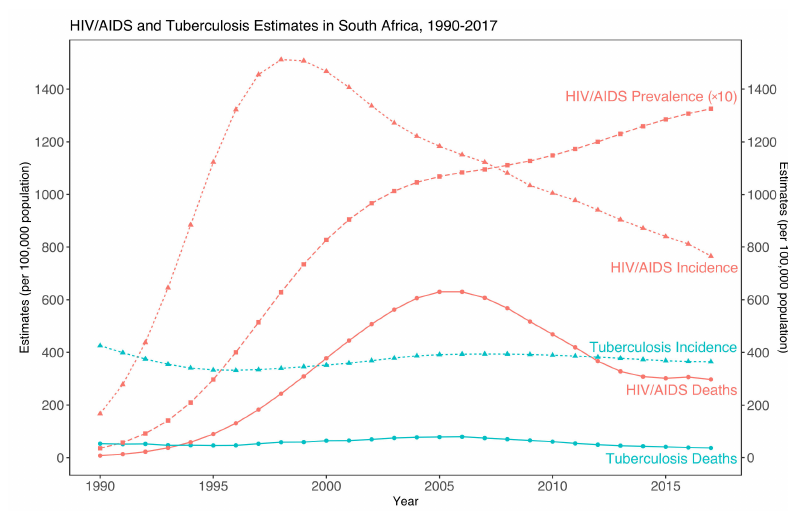
Figure 1. Historical overview of the HIV/AIDS and TB epidemics in South Africa, 1990–2017. Prevalence of HIV/AIDS is divided by 10 for scale. (Adapted from source: